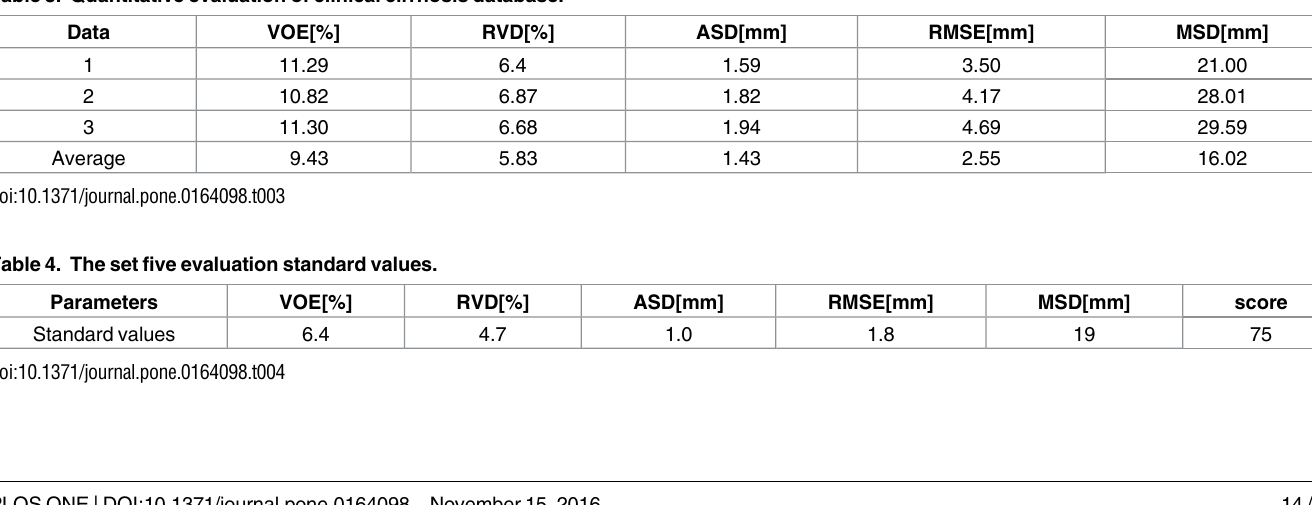
Table 3. Quantitative evaluation of clinical cirrhosis database.